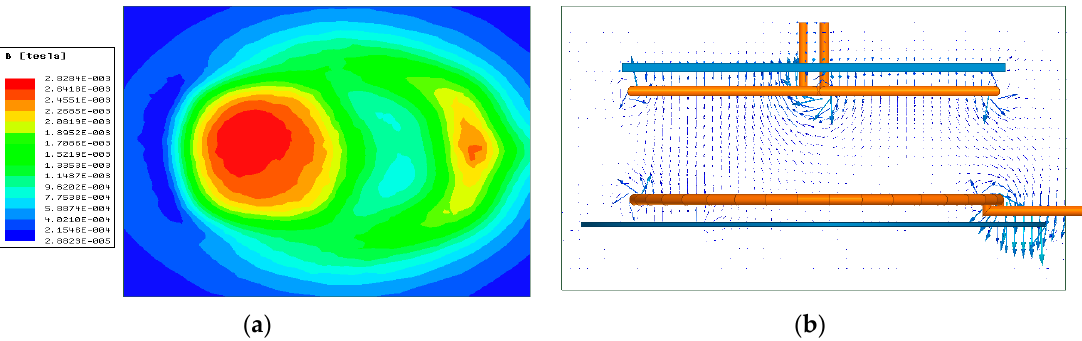
Figure 21. Magnitude plot ( a ) and vector plot ( b ) of the B field between Tx and Rx of the CP–DD configuration. CP–DD configuration.